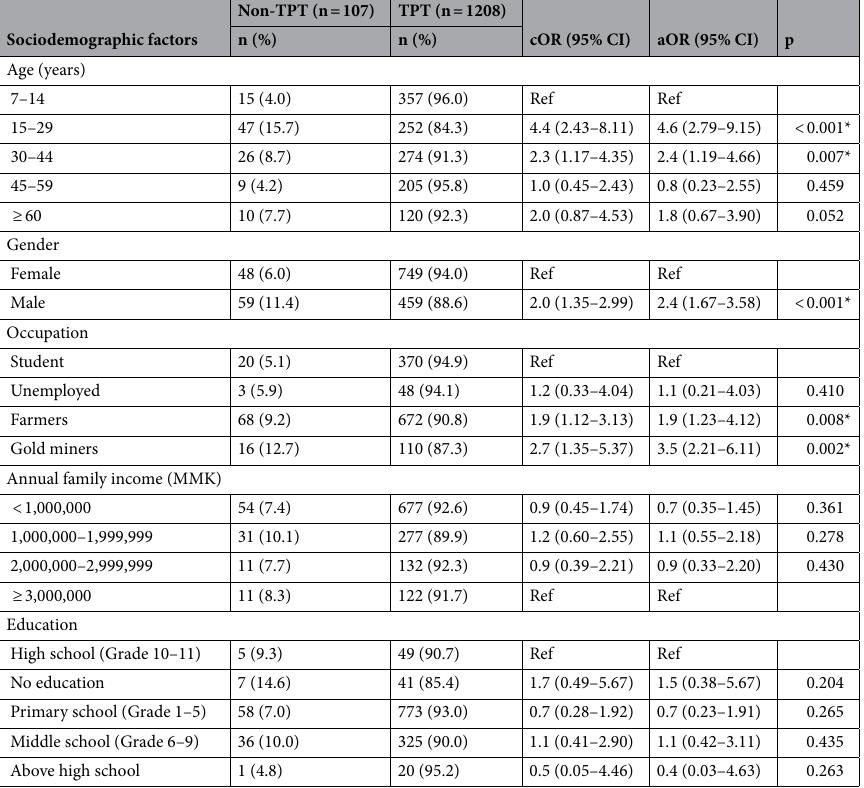
Table 4. Underlying sociodemographic factors for non-participation of eligible samples in targeted primaquine treatment (n = 1315). 1USD˜2100MMK. Other occupation groups including 3 teachers, 2 monks and 3 merchants were involved entirely in TPT and excluded from logistic regression. TPT targeted primaquine treatment, cOR crude odds ratio, aOR adjusted odds ratio, CI confidence interval, Ref. reference. *Significance at p <